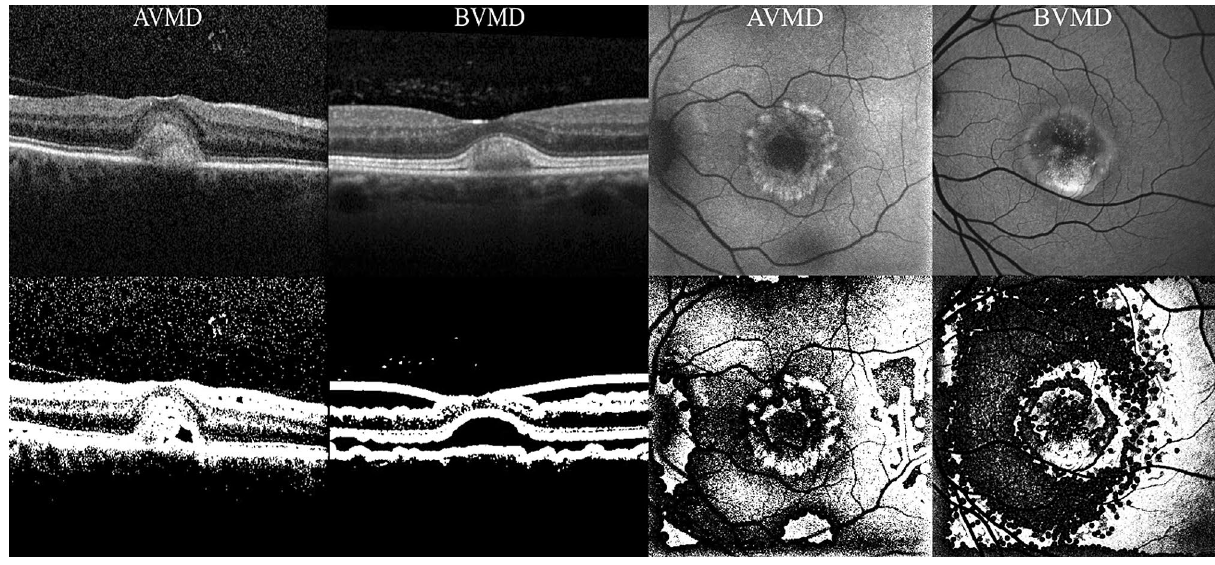
Figure 1. OCT (left quadrant) and BAF (right quadrant) images before (first row) and after (second row) image processing. BAF blue autofluorescence, OCT optical coherence